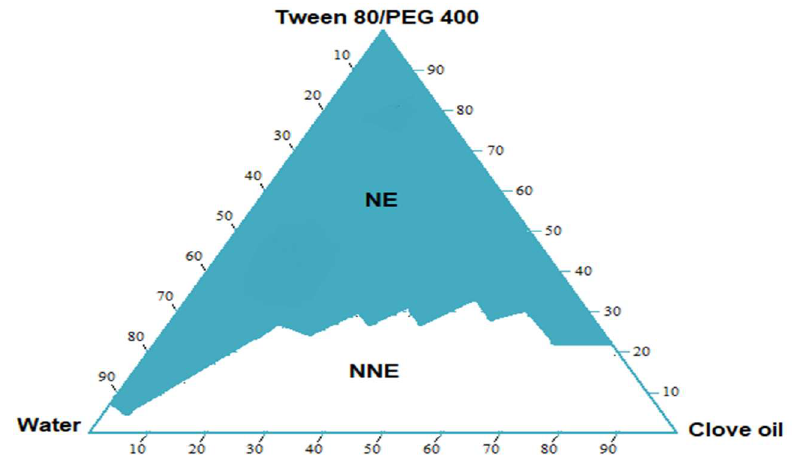
Figure 2. Pseudo-ternary phase diagram consisting of water, clove oil, and Tween 80 + PEG-400 (2:1).